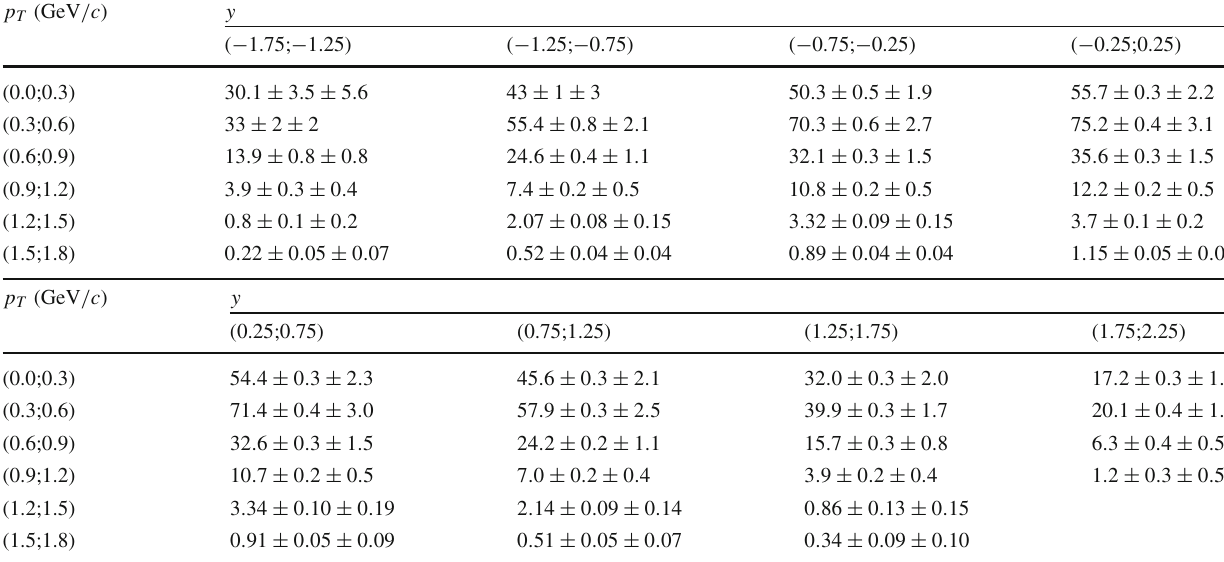
Table 2 Double differential K 0 yields in bins of ( y , p T ). The first uncertainty is statistical, while the second one is S